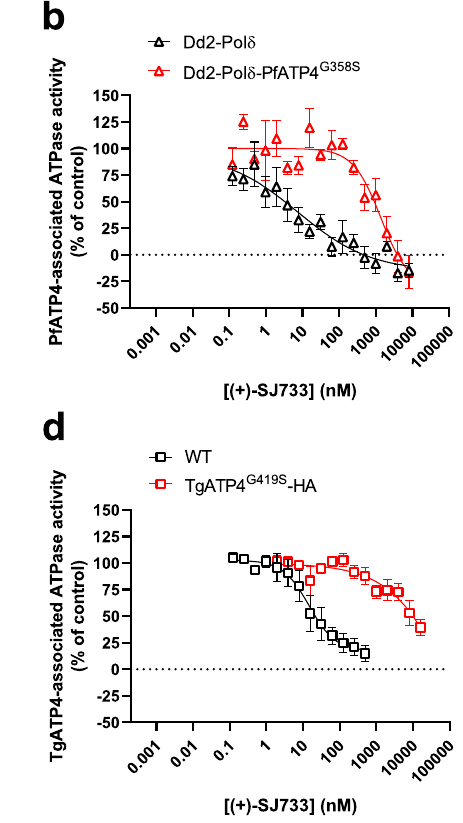
Fig. 4 | Reduced sensitivity of PfATP4 G358S - and TgATP4 G419S -associated ATPase activity to inhibition by cipargamin and (+)-SJ733. The potency by which cipar- gamin ( a , c ) and (+)-SJ733 ( b , d ) inhibit ATP4-associated ATPase activity was determined using membranes prepared from Dd2-Pol δ (black) and Dd2-Pol δ - PfATP4 G358S (red) P.falciparum trophozoites(triangles; a , b )or T.gondii tachyzoites (squares; c , d ) expressing TgATP4 WT (black) or TgATP4 G419S -HA (red). The data are